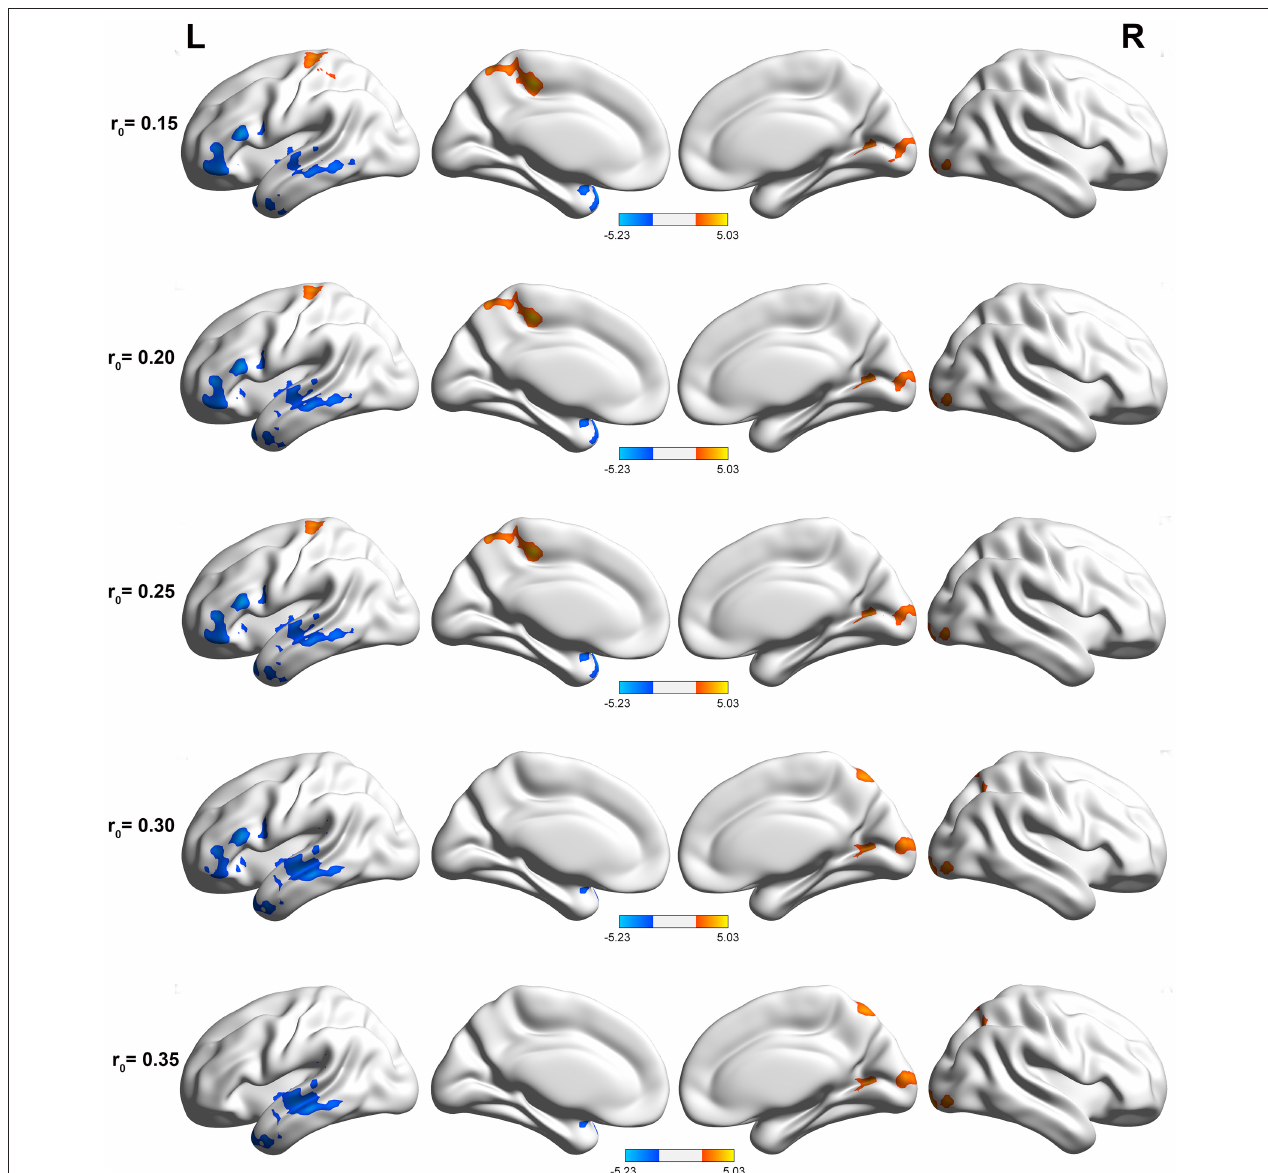
FIGURE 1 | Compared with healthy controls, PI patients exhibited remarkably similar altered DC brain areas in different correlation thresholds ( r 0 = 0.15, 0.2, 0.25, 0.3, and 0.35). The effects are significant at a single voxel p < 0.05, GRF corrected cluster level p < 0.005. The hot (cool) color indicates significantly increased (decreased) DC in the brain